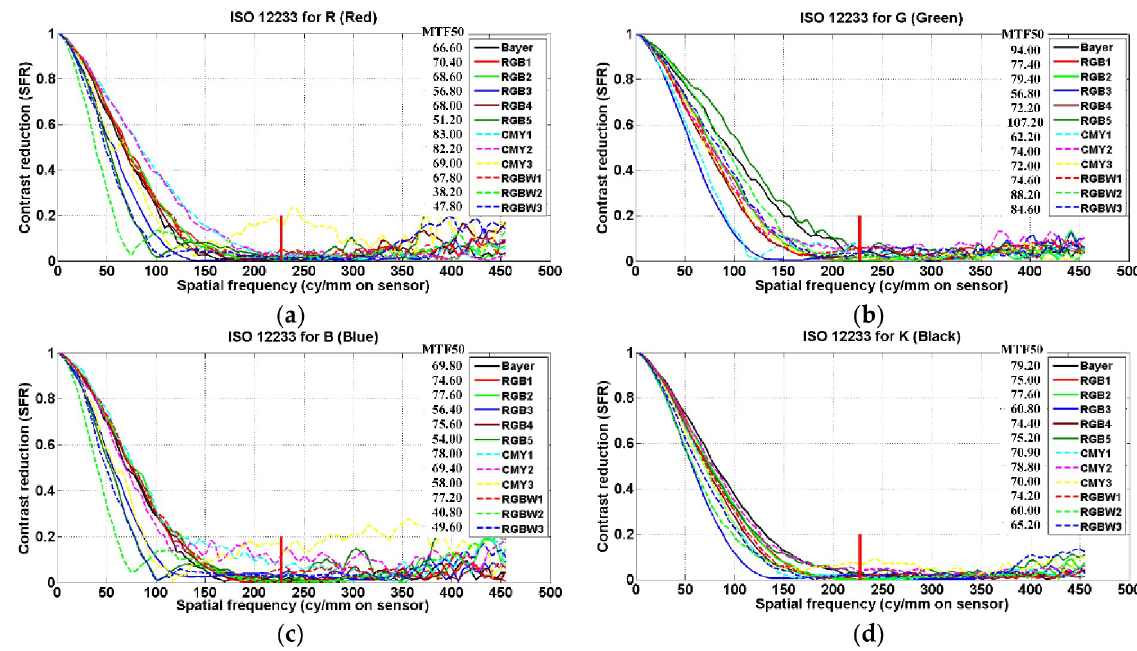
Fig 11. MTF50 of (a) R (red), (b) G (green), (c) B (blue), and (d) K (black) color for test